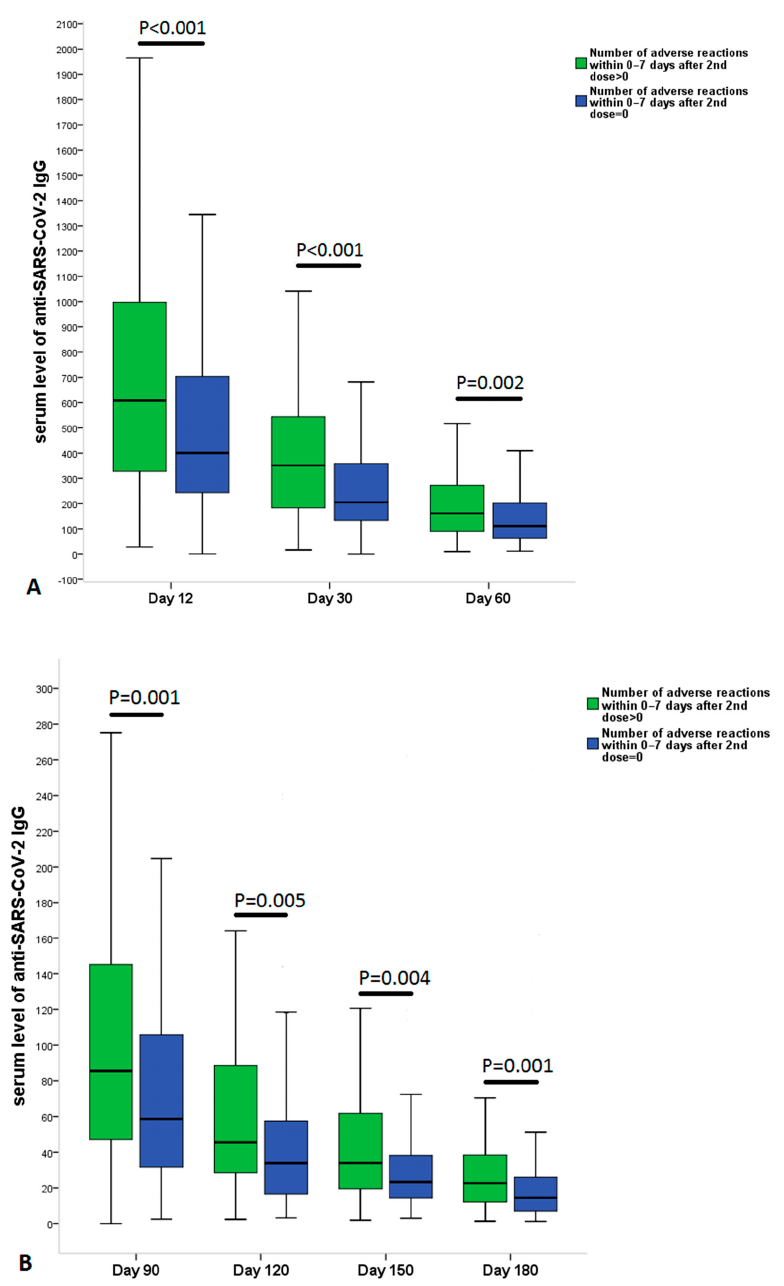
Figure 2. Comparison of serum level of anti-SARS-CoV-2 IgG at ( A ) 12, 30, 60 and ( B ) 90, 120, 150, 180 days after the 2nd dose of vaccination (BNT162b2 mRNA) in patients without or with at least one adverse reaction after each vaccine dose. The data are provided as median and interquartile range. The between-group differences were calculated by the Kruskal–Wallis test.